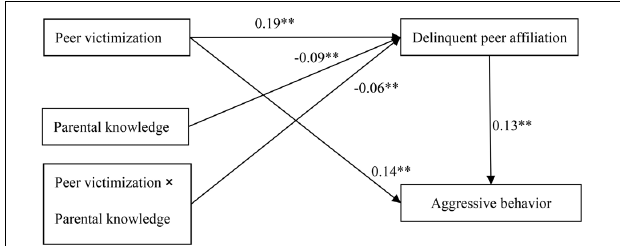
FIGURE 3 | Model of the moderating role of parental knowledge on the indirect relationship between peer victimization and aggressive behavior. Non-significant paths, and paths between gender, age, impulsivity, and each of the variables in the model are not displayed. Of those paths, the following were significant: gender, age, and impulsivity to delinquent peer affiliation ( b 1 = 0.11 ∗∗ , b 2 = 0.02 ∗∗ , b 3 = 0.13 ∗∗ ) and aggressive behavior ( b 1 = 0.10 ∗∗ ,